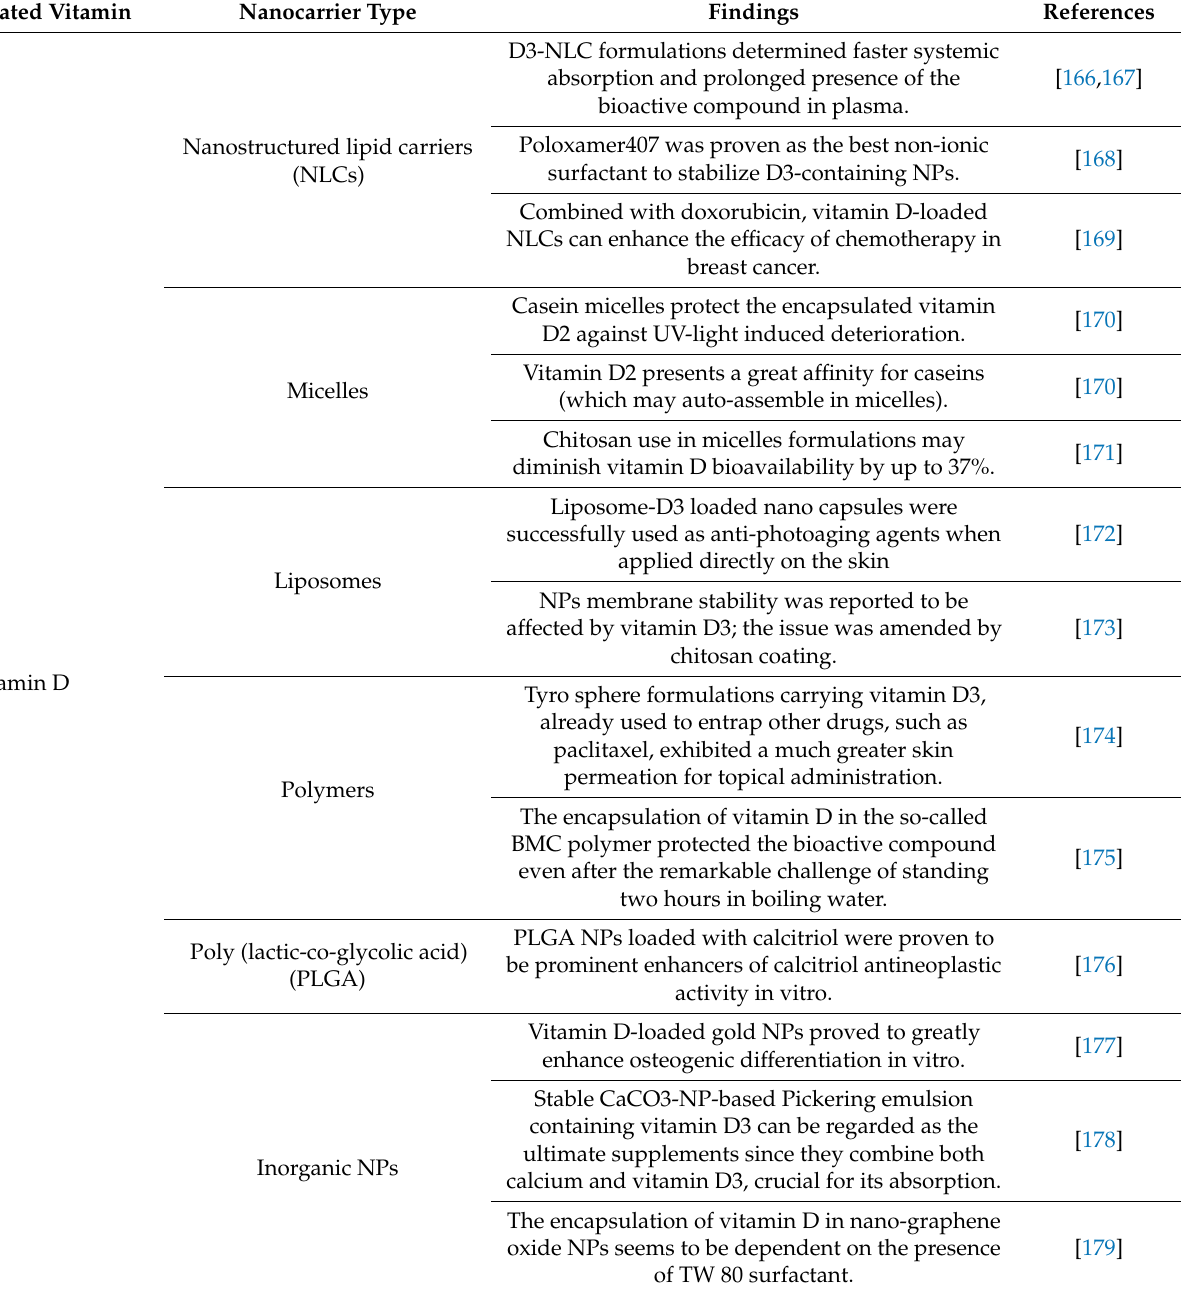
Table 2. Nanoparticle-based formulations for the encapsulation of vitamin